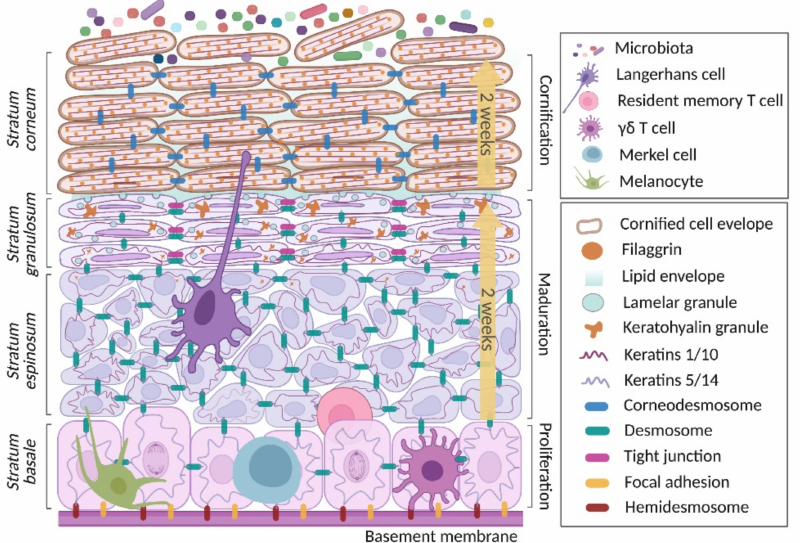
Figure 2. Keratinocyte life cycle. This begins when the keratinocyte (KC) proliferates in the stratum basale. Later, in a course of two weeks, it matures and migrates through the suprabasal layers (spinosum and granulosum stratums) until reaching the top part of the skin, the stratum corneum. Here, the KC acquires the highest degree of maturity and gradually loses viability. Finally, in another two weeks, it moves through the cornified layer to be eliminated by flaking. Created with BioRender.com (access date: 26 August